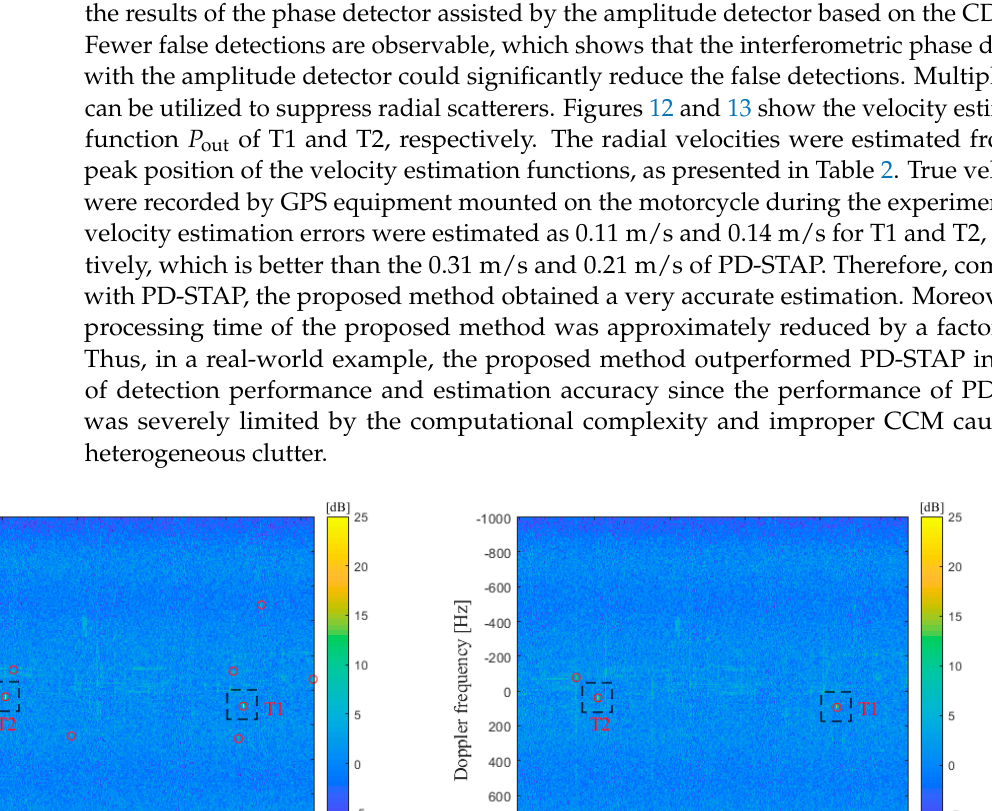
Figure 10. Output normalized SCNR of T2: ( a ) the proposed method; ( b ) PD − STAP.